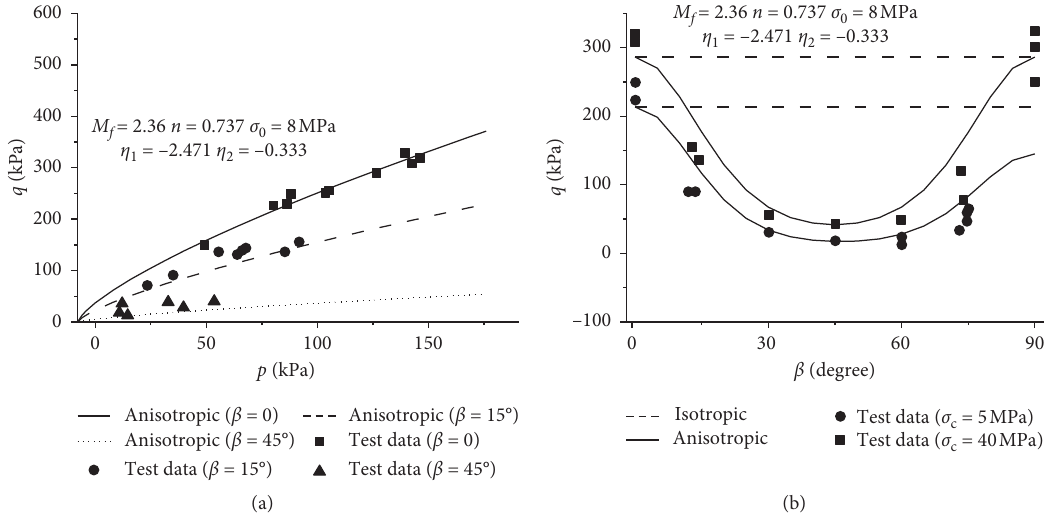
Figure 9: Comparison of the two criteria for Tournemire shale in (a) the p − q diagram and (b) the β − q diagram (test data from [39]; this figure is reproduced from